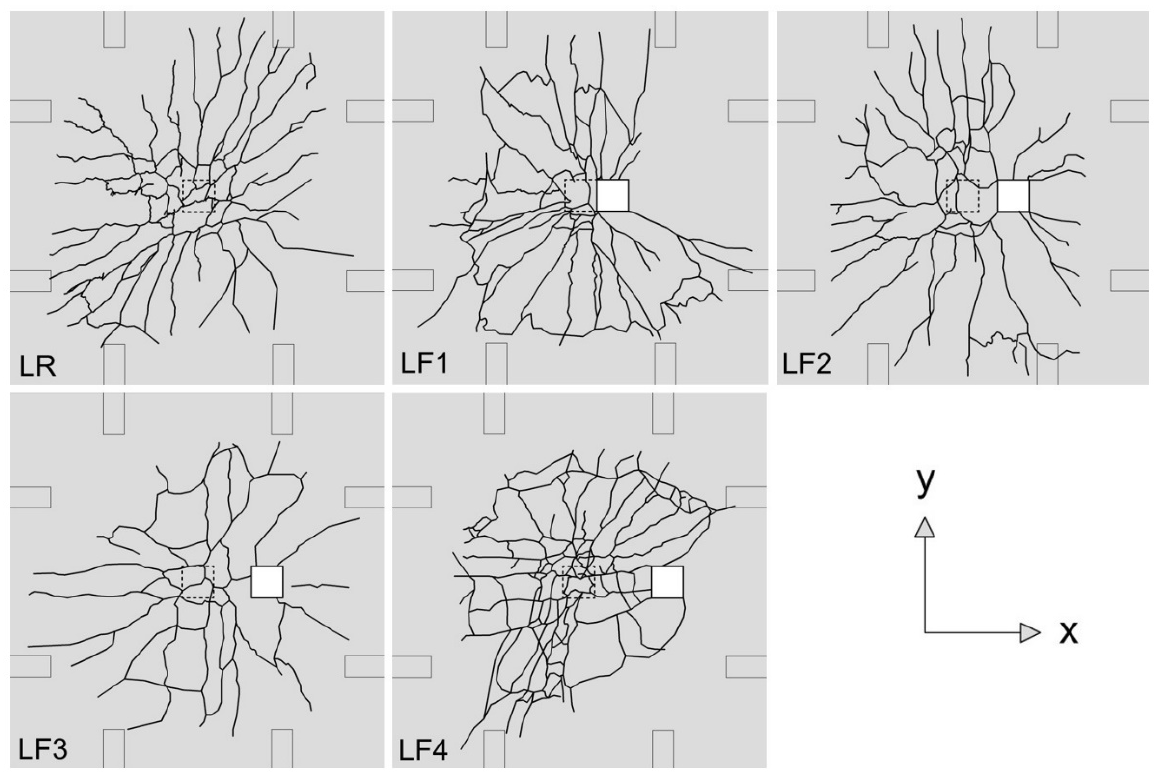
Figure 15. Crack pattern after failure at top surface of